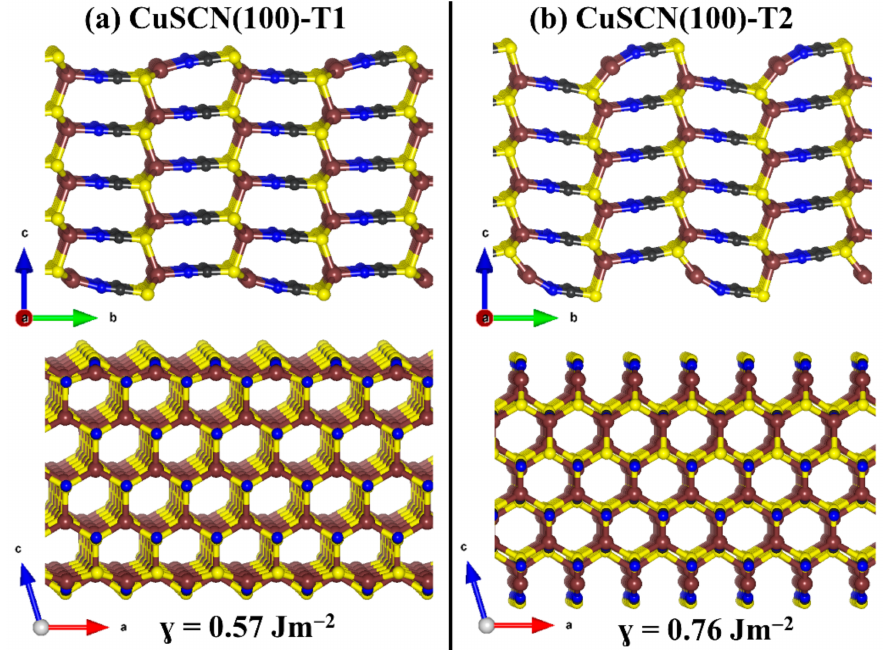
Figure 4. Side views of the optimised structures of the two non-dipolar ( a ) T1 and ( b ) T2 terminations of β -CuSCN (100) surface. Atomic colour: brown = Cu, grey = C, blue = N, and yellow = S.